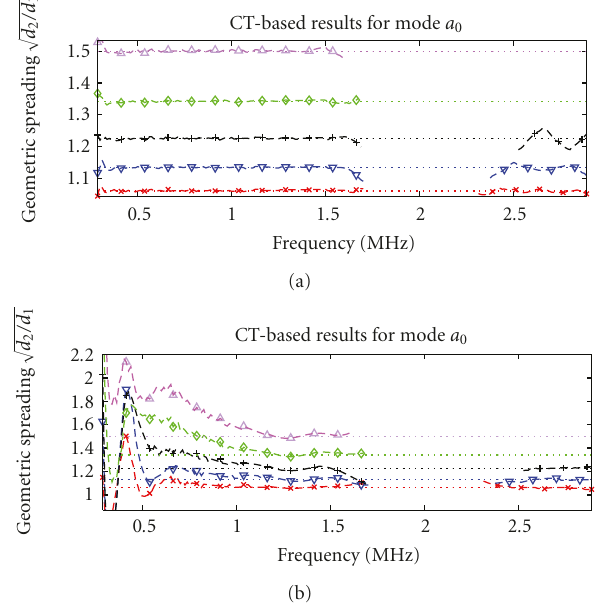
0 -mode of the synthet- ically generated signal determined with the STFT (b) and CT (a). (cid:13) Dashed lines represent the theoretically expected solution d 2 /d 1 , dash-dotted lines are the results obtained from the CT- and STFT- based algorithm, respectively, for the distances 40 mm (pink), 50mm (green), 60 mm (black), 70mm (blue), and 80 mm (red) related to 90mm of propagation